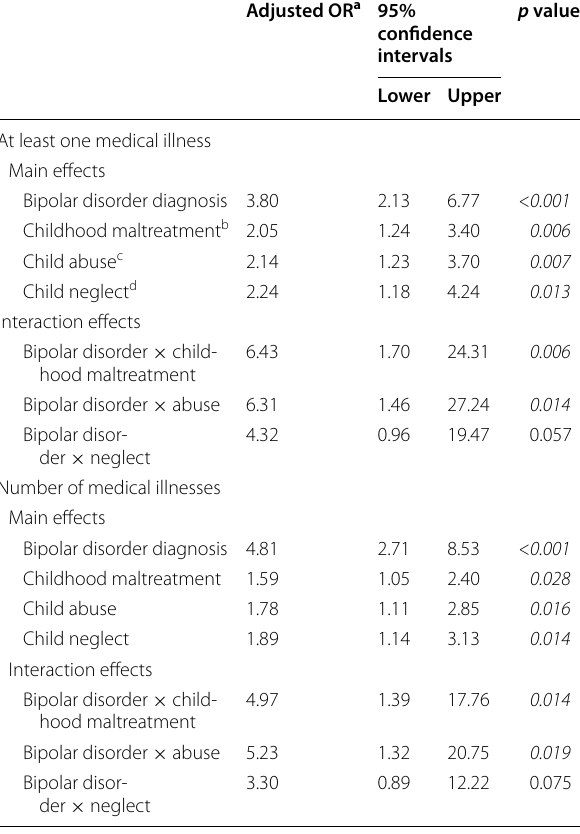
Table 2 Main and interaction effects of bipolar